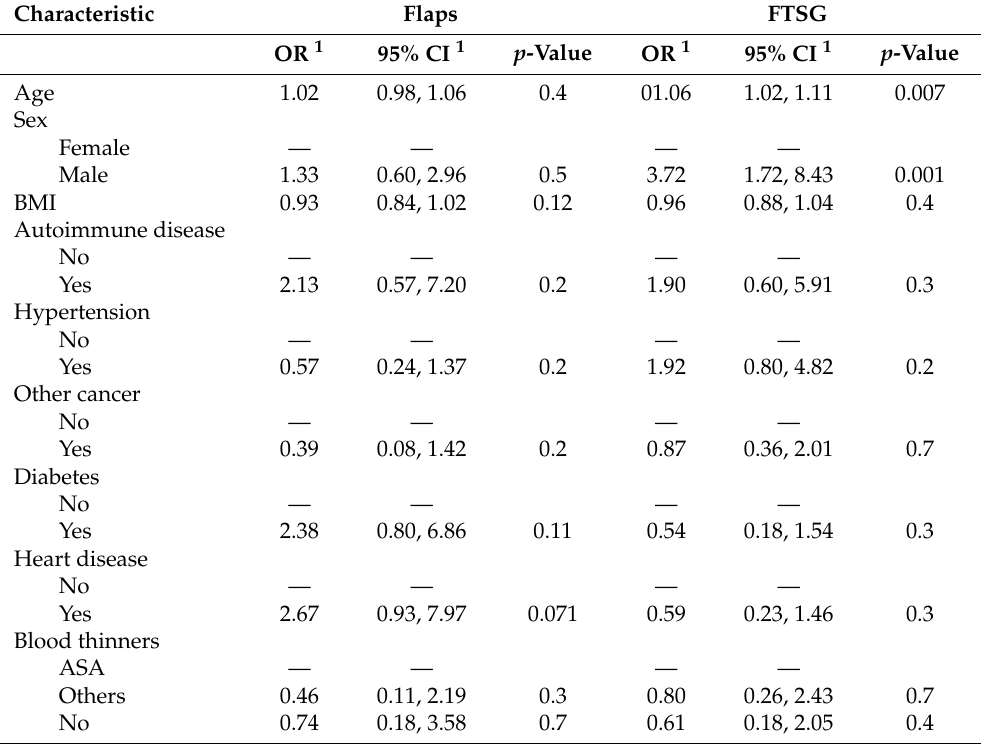
Table 7. Impact of patient demographics on major complications.